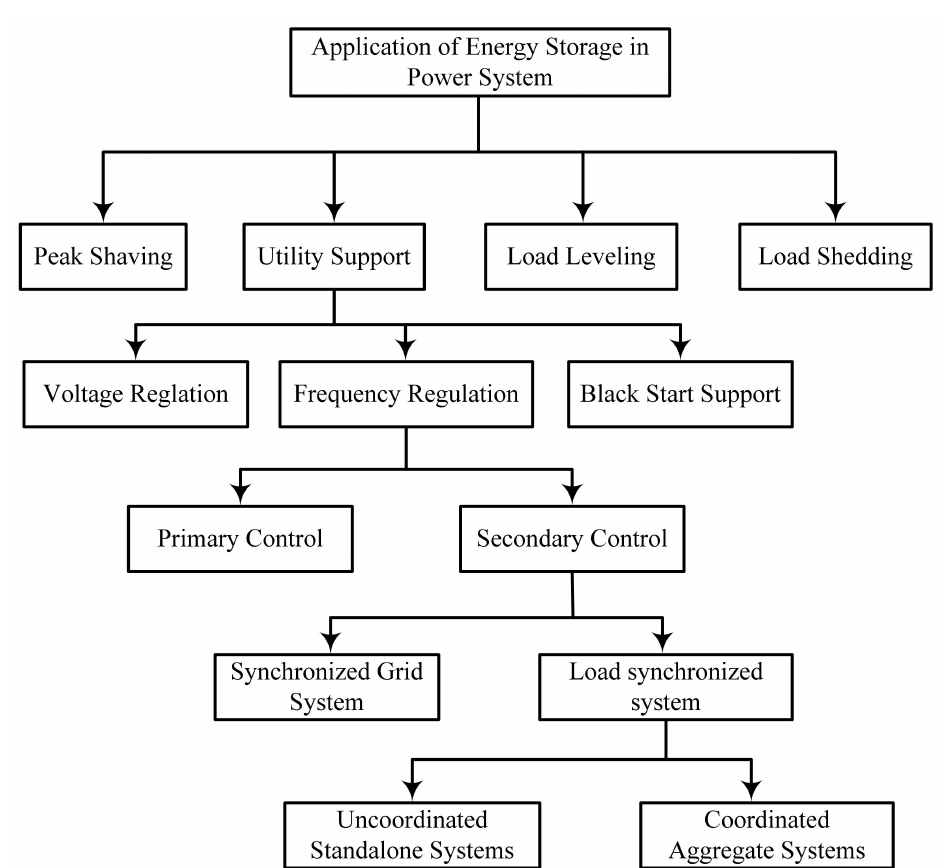
Figure 2. Flow chart showing energy storage application in power system. In Figure 3, a program to control LFM by power storage technology is defined [79]. Based on the volume of the power storage, position and grid control, efficiency, and activity, two types of systems are implemented through different shipping systems.